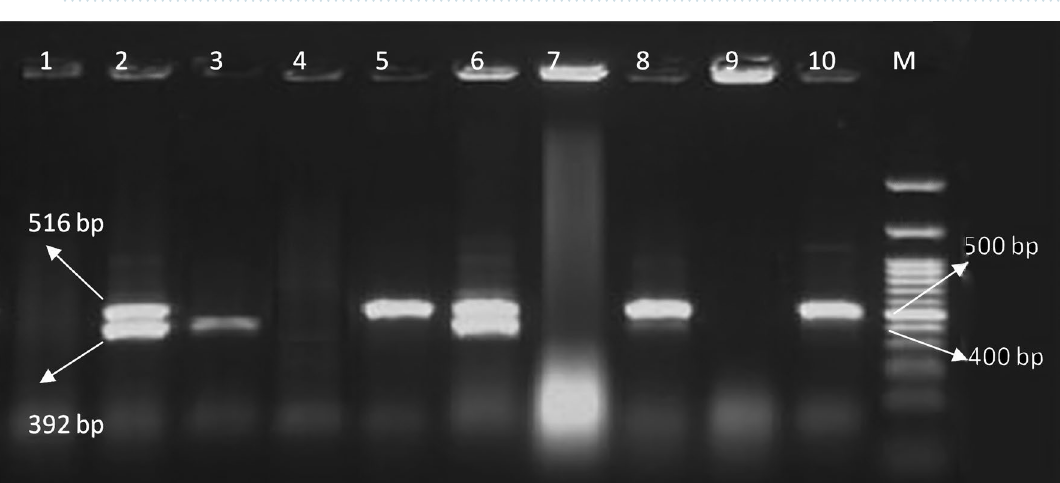
Figure 2. Electrophoresis pattern obtained by multiplex PCR for detection of bla TEM and bla SHV genes in Salmonella isolates. M: marker 100 bp; Lanes 2, 5, 6, 8, and 10: amplification of bla TEM gene at 516 bp; lane 2, 3, 6: amplification of bla SHV gene at 392